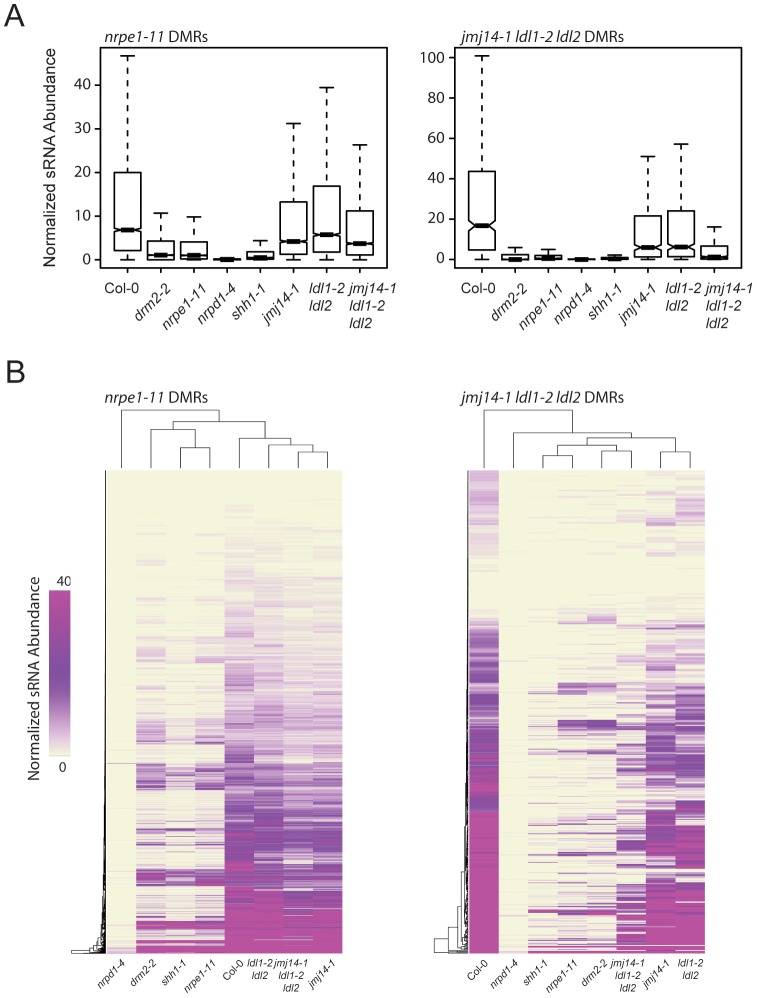

jmj14-1 ldl1-2 ldl2 triple mutants are deficient for sRNA production at affected DMRs.(A) Boxplots of 24-nt siRNA abundance (RPKM) at nrpe1-11 and jmj14-1 ldl1-2 ldl2 DMRs for various mutants. (B) Distance clustered heat map of 24-nt siRNA abundance at DMRs for listed genotypes.